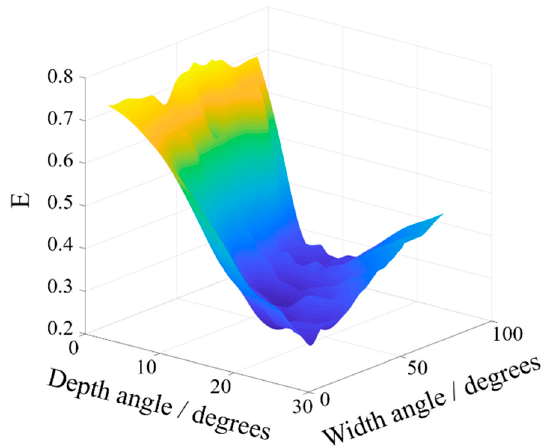
Figure 12. The Figure shows the optimized results of the optimizing index. Table 3. Optimized